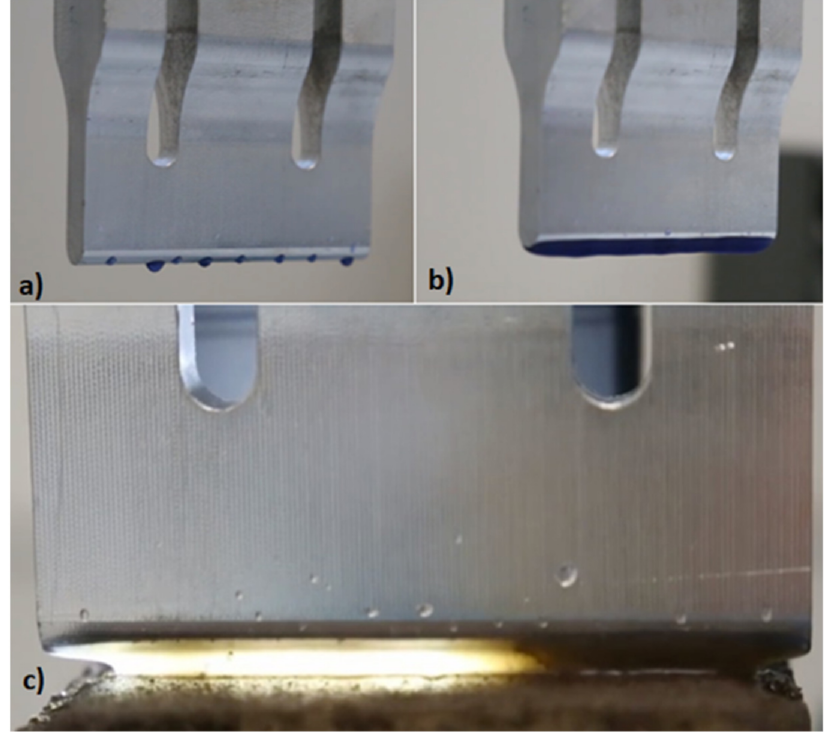
Figure 3. This shows the interaction between the sonotrode and water in different scenarios. The water was treated with blue colorant to allow for a better visualization. ( a ) No ultrasonic vibration. ( b ) Ultrasonic vibration at 20 kHz and 10-micron amplitude. ( c ) Non-immersion cleaning on a dirty surface. 5 mm